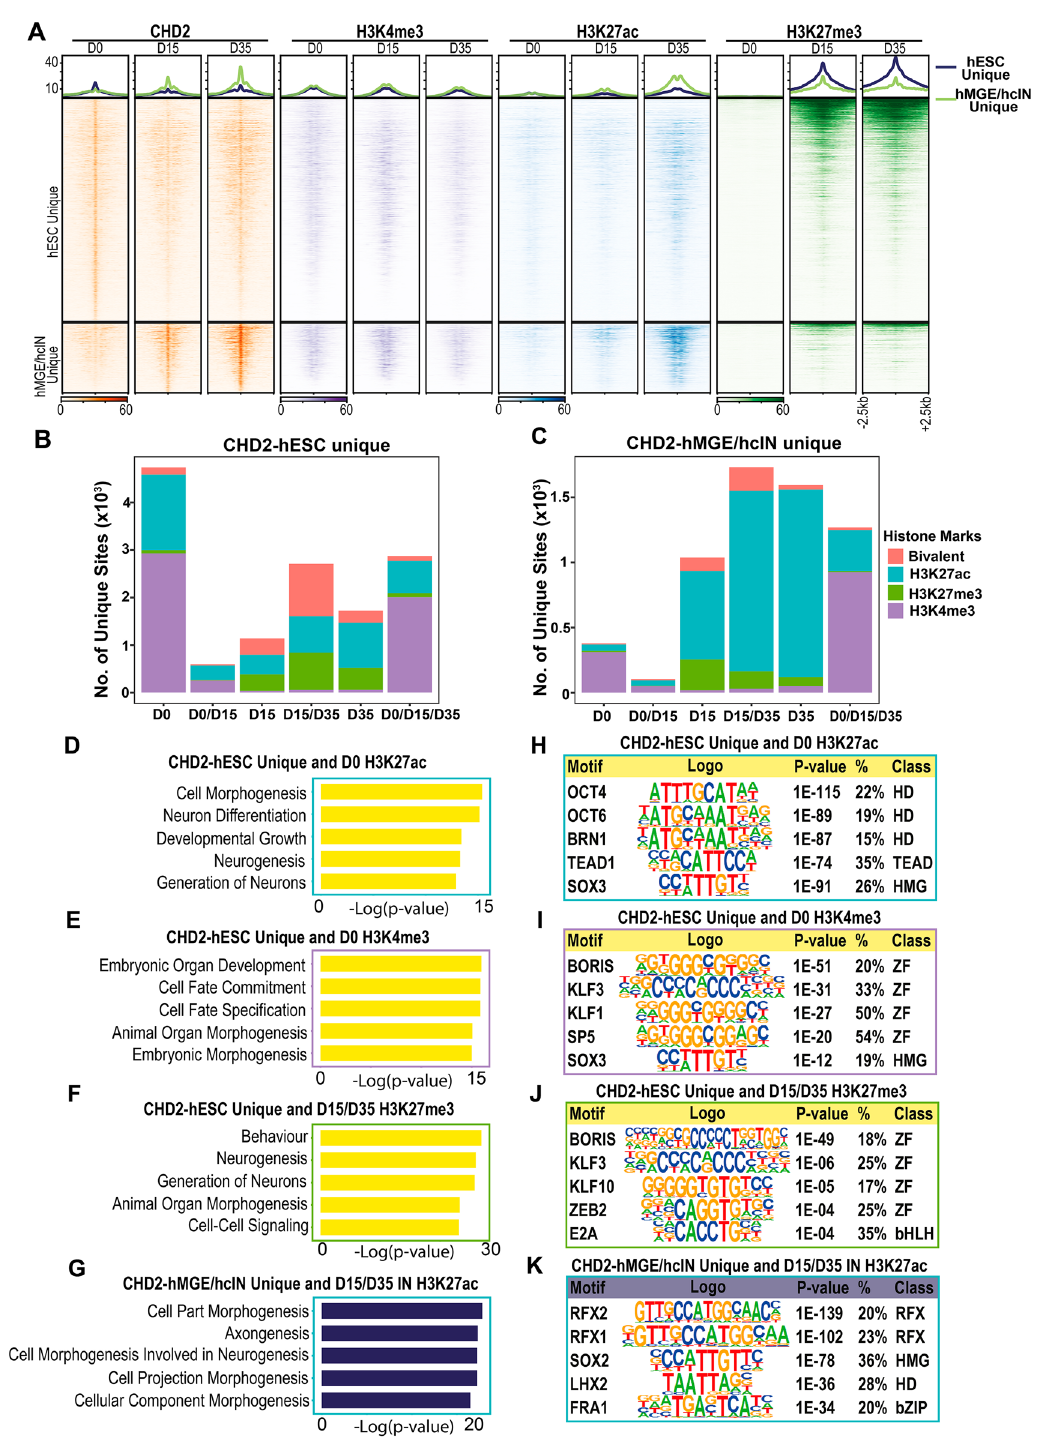
Figure 4. Histone modification states associated with CHD2 binding during hcIN differentiation. ( A ) Signal enrichment of H3K4me3, H3K27ac, and H3K27me3 modification around CHD2 bound peaks in hESCs, hMGEs, and hcINs. Line plots at top: averaged signal for CHD2 binding and histone modification in the hESC unique CHD2 peak cluster (upper panels) and the hMGE/ hcIN unique peak cluster (lower panels), respectively. ( B , C ) Coenrichment of histone modifications with CHD2 bound peaks. For CHD2-bound peaks that were ( B ) unique to hESCs or ( C ) unique to hMGEs and/or hcINs but not hESCs, the number of unique overlapping peaks for each histone modification at the time indicated in days ( D ) is shown. Bivalent status was defined by the intersection between H3K4me3 and H3K27me3 peaks. ( D – F ) Gene ontology (GO) enrichment analysis of genes associated with CHD2 peaks unique to hESCs and enriched for ( D ) H3K27ac at D0, ( E ) H3K4me3 at D0, or ( F ) H3K27me3 at either/or D15 or D35. ( G ) Gene ontology (GO) enrichment analysis of genes with a CHD2 peak in hMGEs and/or hcINs and associated with H3K27ac at either/or D15 or D35, with p-values for top terms (expressed as -log10) shown. ( H – J ) Transcription factor binding site enrichment under CHD2 peaks unique to hESCs and enriched for ( H ) H3K27ac at D0, ( I ) H3K4me3 at D0, or ( J ) H3K27me3 at either/or D15 or D35. ( K ) Transcription factor binding site enrichment under CHD2 peaks in hMGEs and/or hcINs that were coenriched for H3K27ac at either/or D15 or